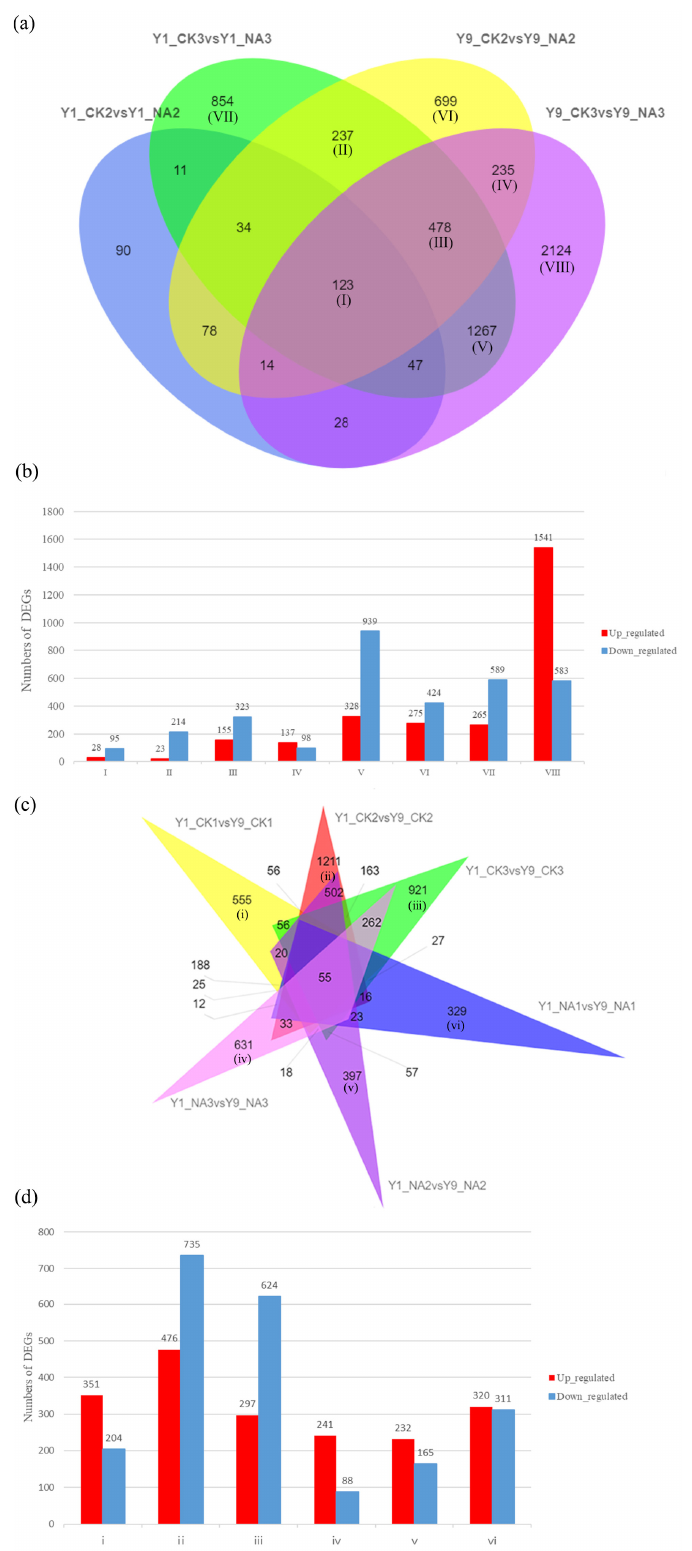
Figure 2. Venn analysis and bar charts of DEGs during salt stresses. ( a ) Venn diagram of DEGs due to 250 mM salt treatment. ( b ) Number of upregulated and downregulated genes corresponding to each part of ( a ). ( c ) Venn of DEGs caused by salt resistance. ( d ) Number of upregulated and downregulated genes corresponding to each part of ( c ). I–V indicate overlapped DEGs between Y1_CK2 vs.